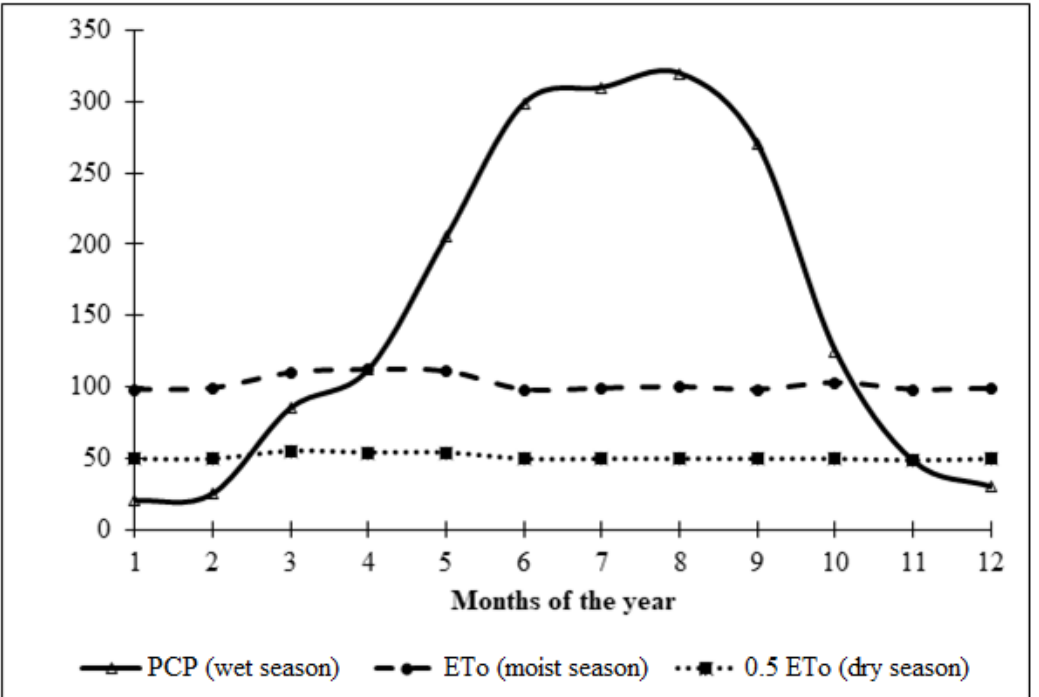
ff erent Agro-ecological